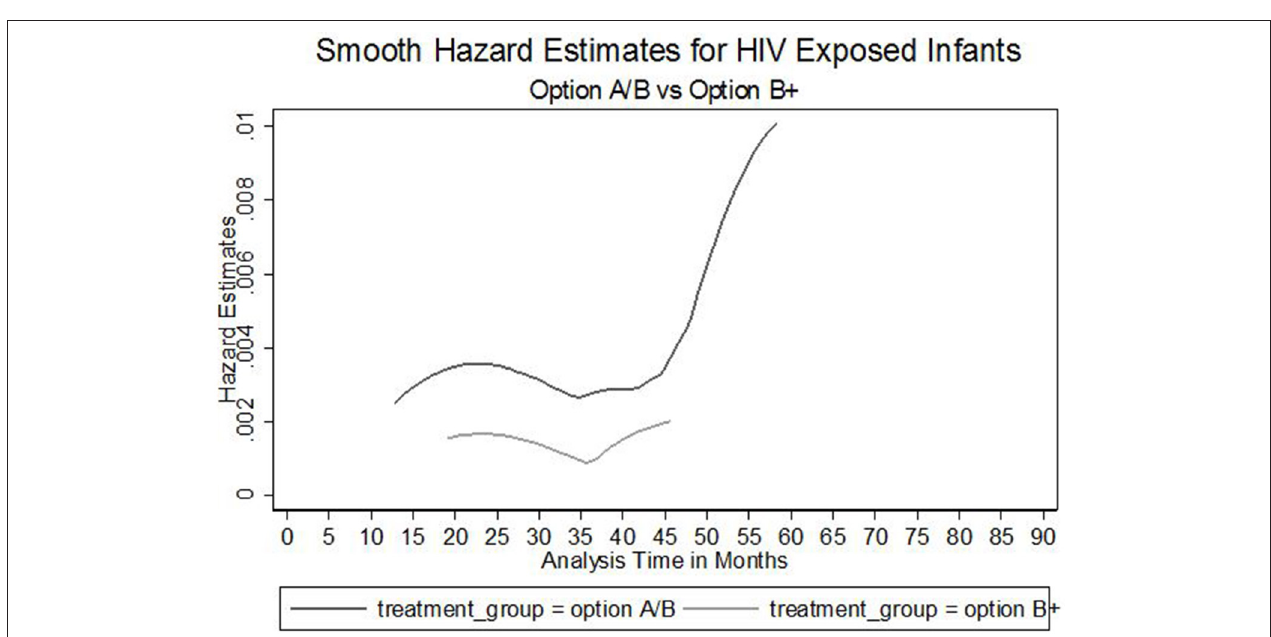
FIGURE 3 | Smooth hazard estimates for HIV exposed infants by treatment